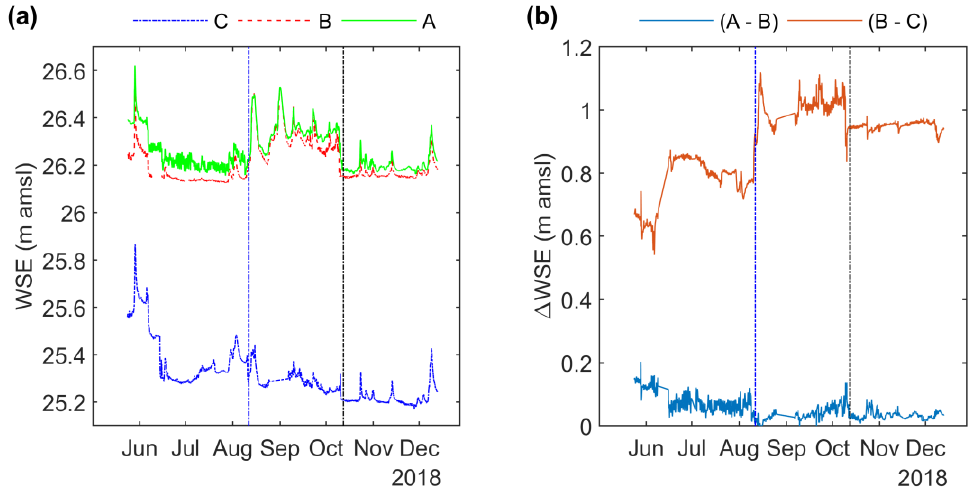
Figure 3. In-situ water surface elevation(WSE) ( a ) from the three gauging stations, as shown in Figure 1, and the WSE differences ( b ) between the adjacent stations. The blue and black dash dot lines indicate the dates of vegetation cutting activities. Note that, gauges A, B, and C are located from upstream to downstream, as indicated in Figure 1.